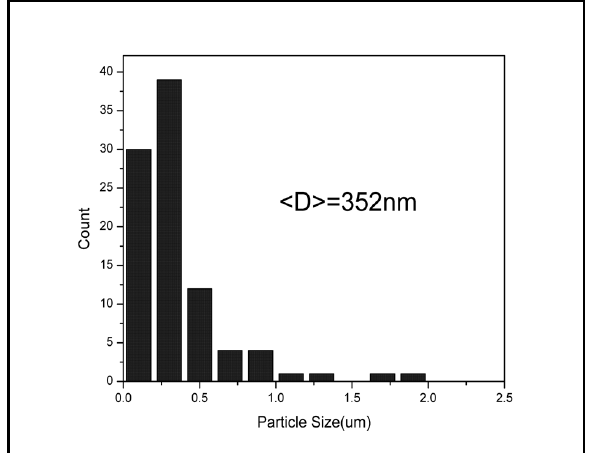
Fig. 3 Three step milling run particle size